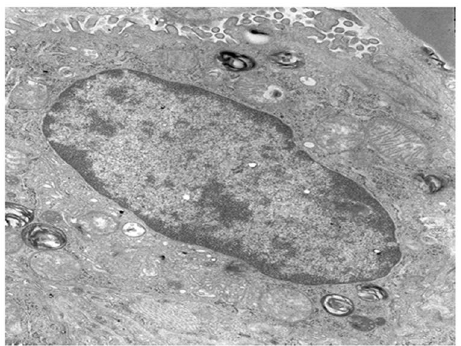
Figure 8. The Type II alveolar epithelial cells from the PQ group ( 6 8000). The nuclei were collapsed and contained dense heterochro- matin; the endoplasmic reticulum tended to be vesiculated, the basement membranes were absent or disrupted, the mitochondria was vacuolated and the number of lamellar bodies clearly decreased.